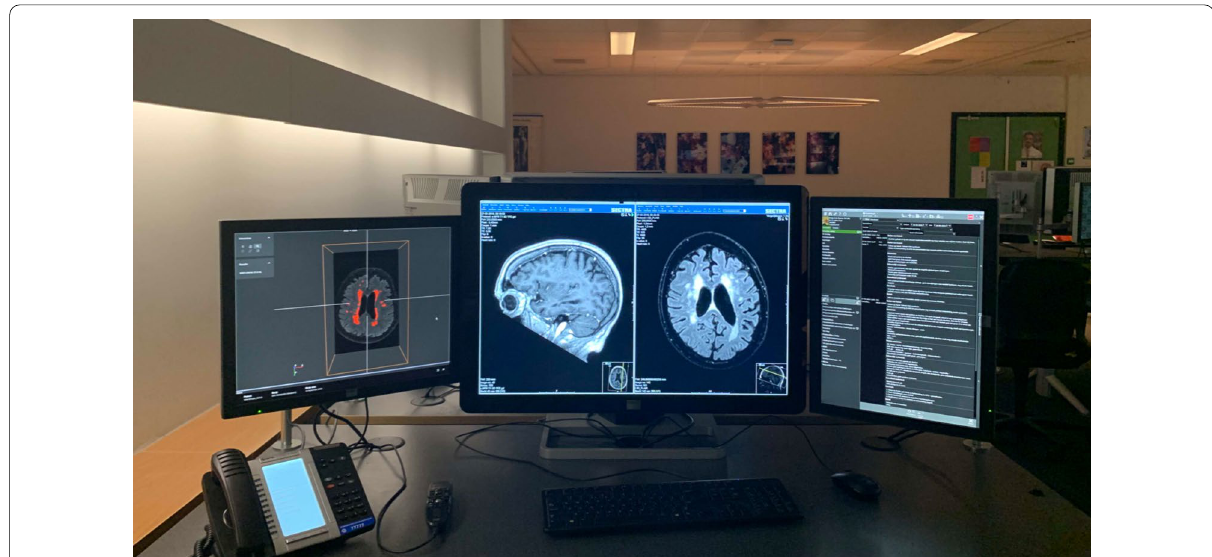
Fig. 5 Example of VNAI integration in clinical workflow. The PACS system (middle monitor) and hospital information system (right monitor) running side-by-side. The left monitor shows the output of a white matter hyperintensity quantification algorithm [17]. The user can scroll through the stack of images and correlate the algorithms output with the source images in the